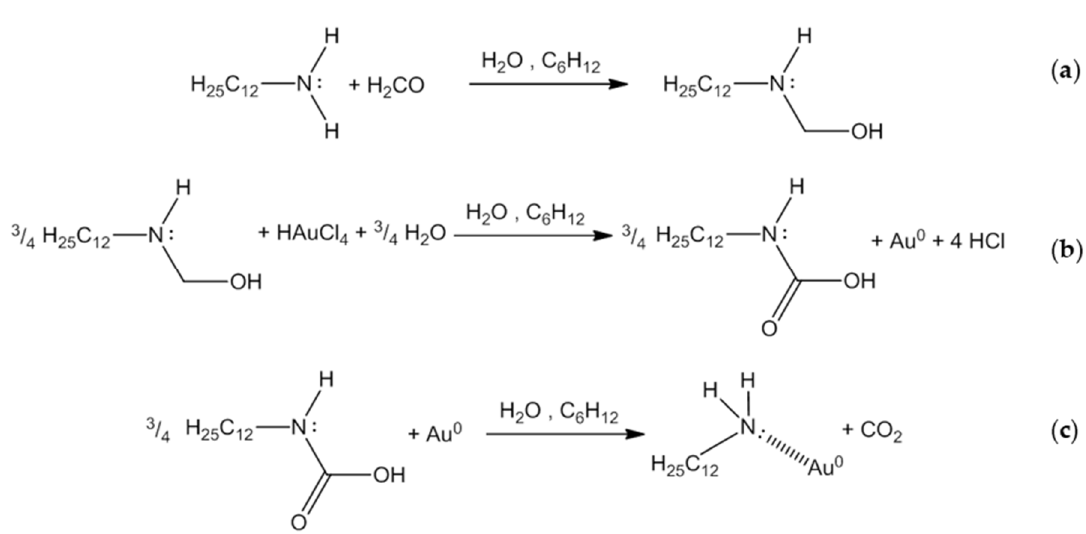
Figure 10. Au-DDA formation mechanism. ( a ) formation of the reductive intermediate dodecylaminomethanol from DDA and formaldehyde, ( b ) Reduction of gold precursor HAuCl 4 to metallic gold and oxidation of dodecylaminomethanol into dodecylcarbamic acid and ( c ) decomposition of dodecylcarbamic acid into DDA and interaction of the latter with metallic